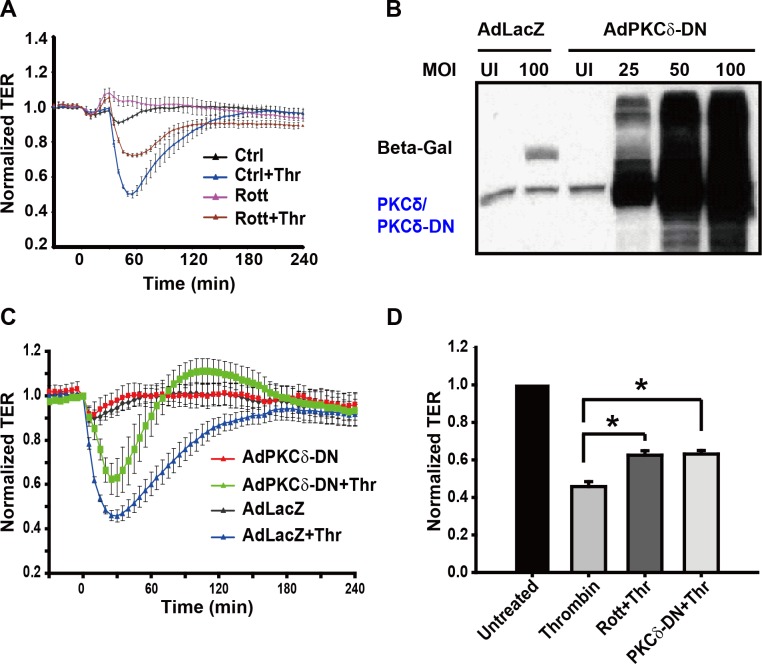
Effects of rottlerin pretreatment and expression of dominant negative PKCδ on thrombin-induced endothelial barrier dysfunction.(A) EC monolayer leakiness was assessed by measuring TER in EC pretreated with rottlerin (10 μM, 30 min), a PKCδ inhibitor, followed by thrombin stimulation (1 U/ml, 15 min). Error bars = ± SE. (B) EC were infected with either control adenovirus (AdLacZ) or Ad PKCδ-DN (MOI: multiplicity of infection). After 3 d, cells were lysed and immunoblotted. (C) Infected EC (MOI = 25) were then challenged with thrombin (1 U/ml) and TER (normalized to basal resistance) measured over time. Error bars = ± SE. (D) Maximum decrease in TER (normalized to basal resistance) in EC treated with either rottlerin or infected with Ad PKCδ-DN is shown. (n = 6/condition, * p < 0.05).